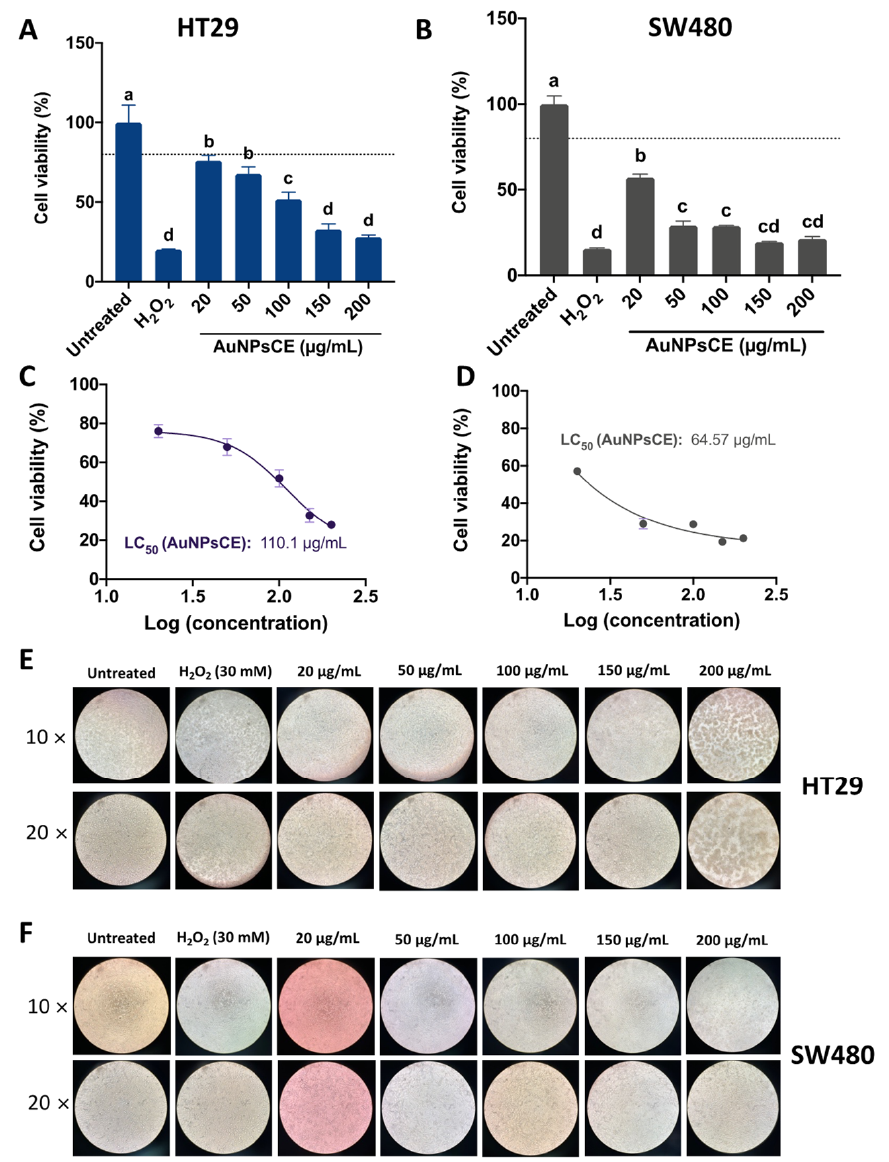
Figure 5. Impact of castor bean ( R. communis ) leaves ethanolic extracts-based gold nanoparticles (AuNPsCE) on HT29 and SW480 cells viability. ( A ) Effect of AuNPsCE in HT29 cells viability; ( B ) Influence of AuNPsCE in SW480 cells viability; ( C ) Quantified IC 50 of AuNPsCE treatments on HT29 cells; ( D ) Quantified IC 50 of AuNPsCE treatments on SW480 cells; ( E ) Representative pictures (10 × and 20 × ) of AuNPsCE impact on HT29 cells; ( F ) Representative pictures (10 × and 20 × ) of AuNPsCE impact on SW480 cells. Hydrogen peroxide (H 2 O 2 )-treated cells (30 mM) were used as a positive control. Untreated cells (DMEM + 0.5% ASB) were used as a negative control. Pictures from untreated controls were the same as AuNPsME and AuNPsCS. For Figure 5A,B different letters (a, b, c, d) express significant differences ( p < 0.05) by Tukey-Kramer’s test. The dashed line in ( A , B ) represent 80% cell viability.